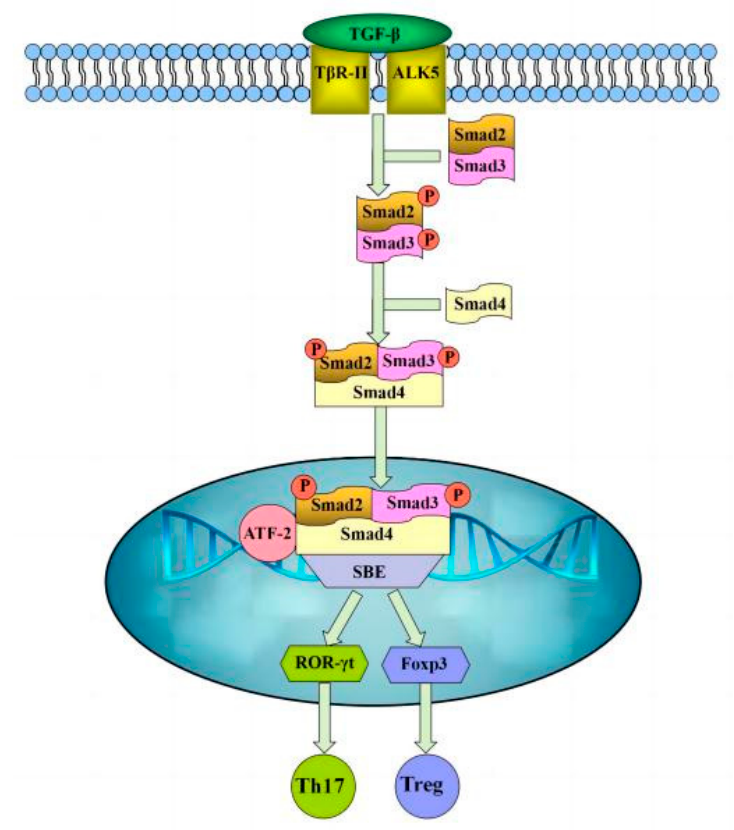
Figure 1. TGF- β signaling pathway.